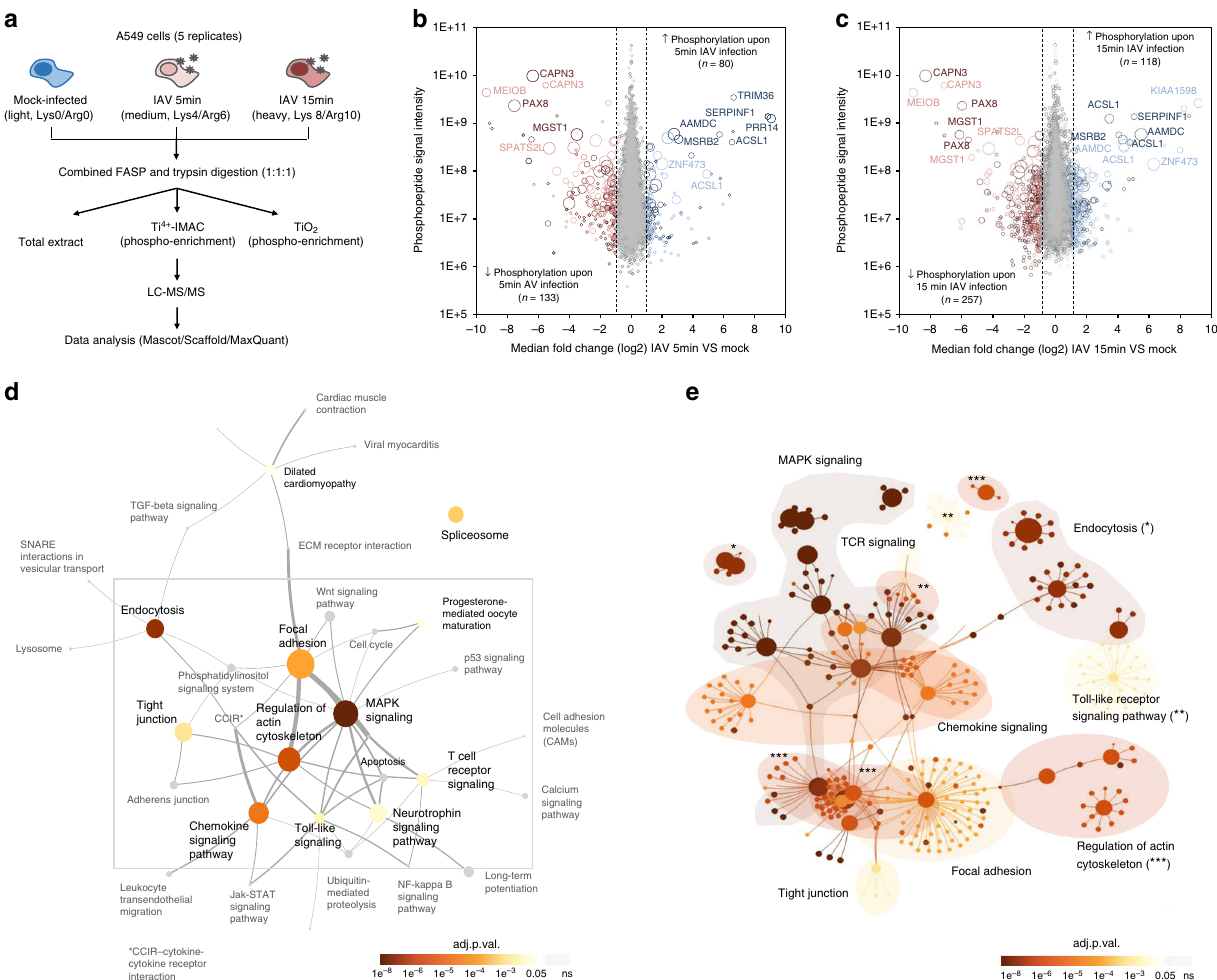
Fig. 1 IAV-induced changes in the host cell phosphoproteome. a Overview of the experimental design. b , c Distribution of changes in cellular phosphorylation after 5 ( b ) and 15 ( c ) min of infection of A549 cells with IAV strain A/WSN/33 at MOI = 25 PFU/cell. Median fold-changes in phosphorylation of the identi fi ed phosphosites are presented in relation to the intensity of detection. Dephosphorylated peptides are shown in red and hyper-phosphorylated ones in blue. Darker colors are used for the results of the Ti + 4 chromatography, lighter colors for TiO 2 . The size of the circles re fl ects the number of biological replicates in which a given peptide was identi fi ed. The names of the proteins for the main differentially phosphorylated peptides are indicated. d The main IAV-responsive pathways are represented by circles in the context of the KEGG pathway topology. The size of the circles re fl ects the number of differentially phosphorylated peptides, while the color indicates the signi fi cance of enrichment from the standard hypergeometric test. Edge width corresponds to the number of shared components between a pair of KEGG networks. e The differentially phosphorylated proteins in the top enriched pathways are represented in the context of a functional association network. Asterisks are used to identify small or distant nodes for the represented pathways. Vertices are colored based on the adjusted p -values for enrichment from the standard hypergeometric